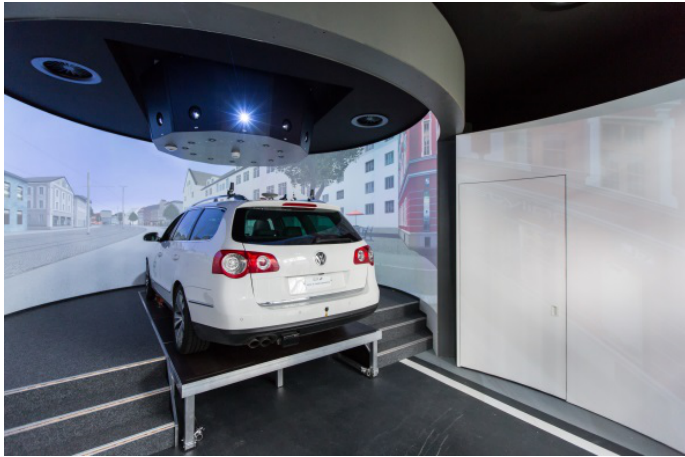
Figure 4: FASCar ® -II inside VR-Lab